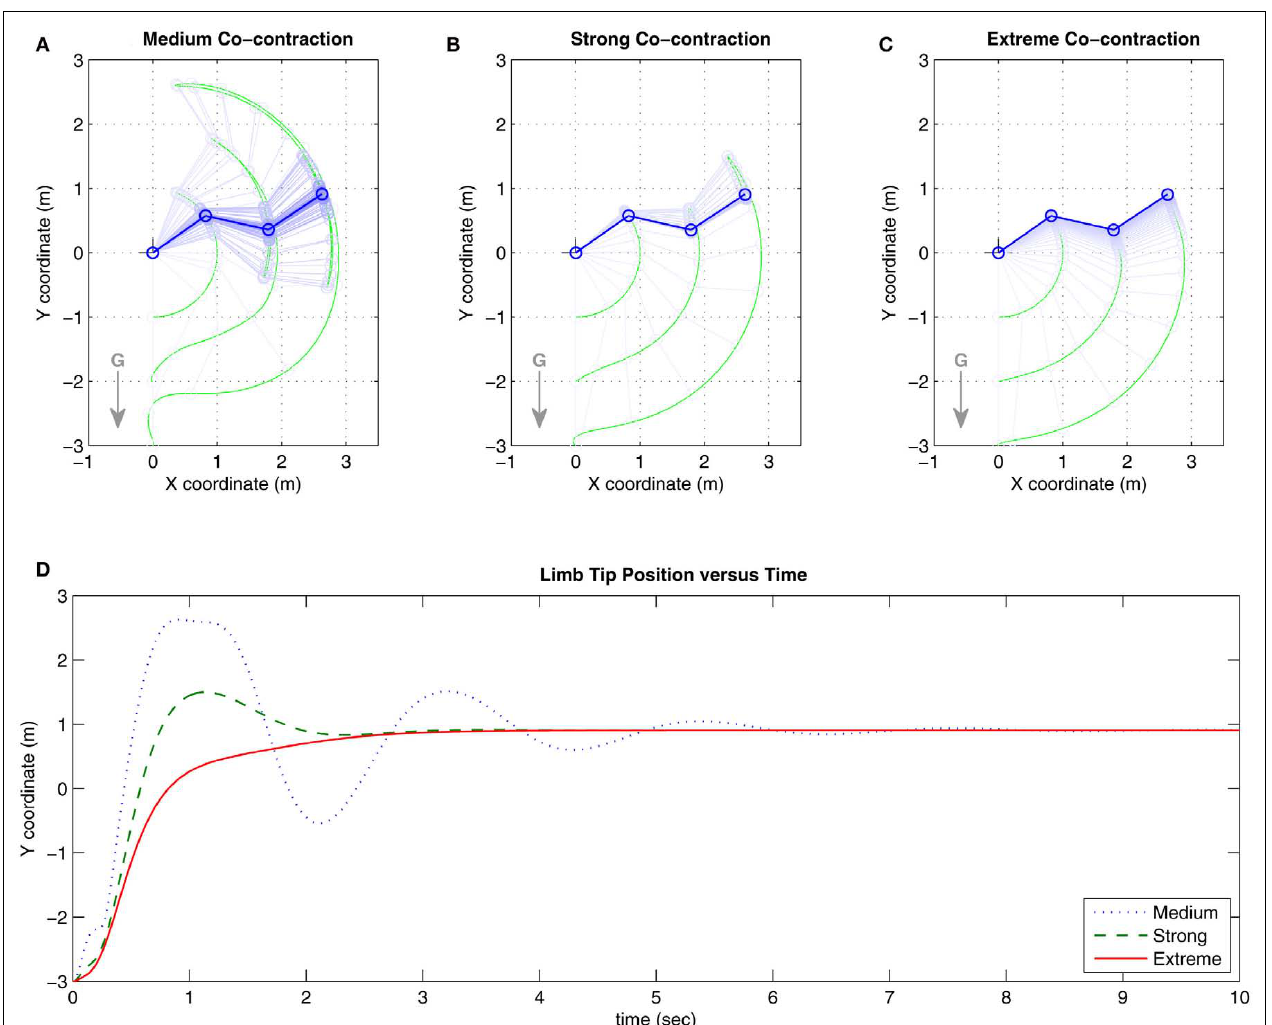
approximates the mathematical limit of co-contraction. Limb position is sampled at 0.1s intervals in all three panels. (D) Tracks the vertical position of the limb tip for each co-contraction condition. Damping in the full biomechanical limb is observed to increase with higher levels of co-contraction, consistent with the findings for the isolated limb segment. See Movie S1 in Supplementary Material for an animated version of this figure.